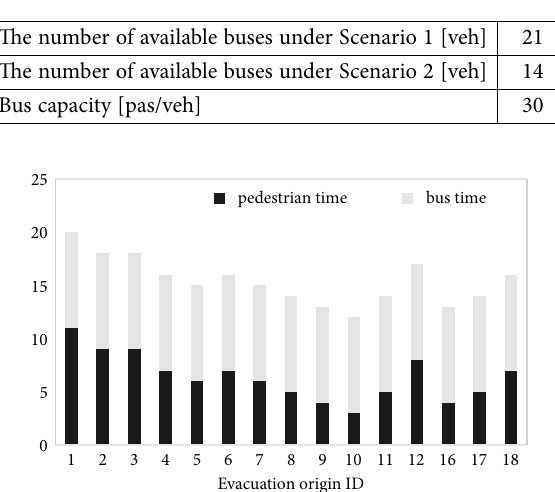
Table 3. The bus information under Scenarios 1 and 2